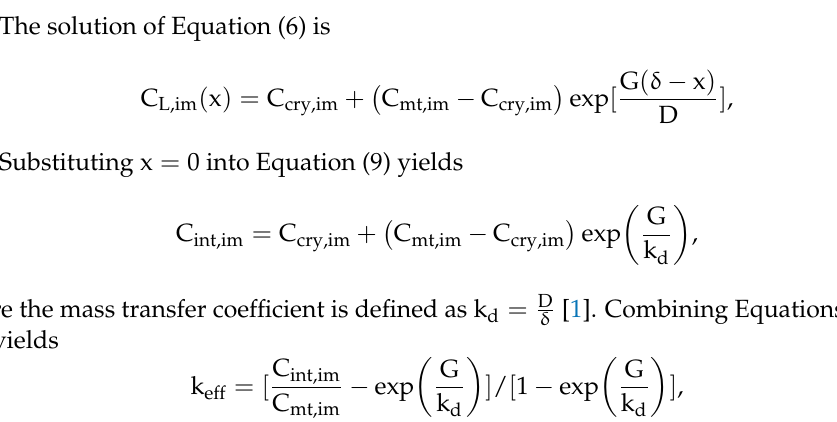
Figure 6. Schematic diagram of the impurity concentration in the mass transfer boundary layer along the x direction perpendicular to the crystal–melt